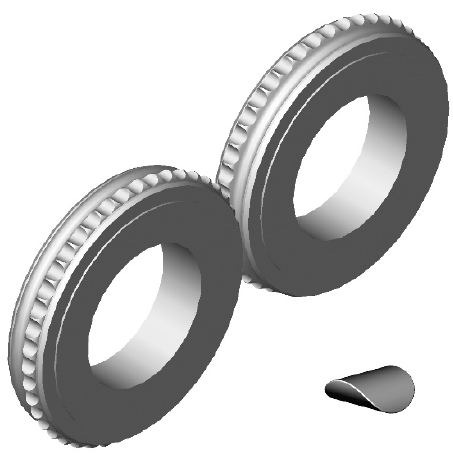
Figure 2. Moulding rings used in roller press compaction unit with a saddle-shaped briquette.